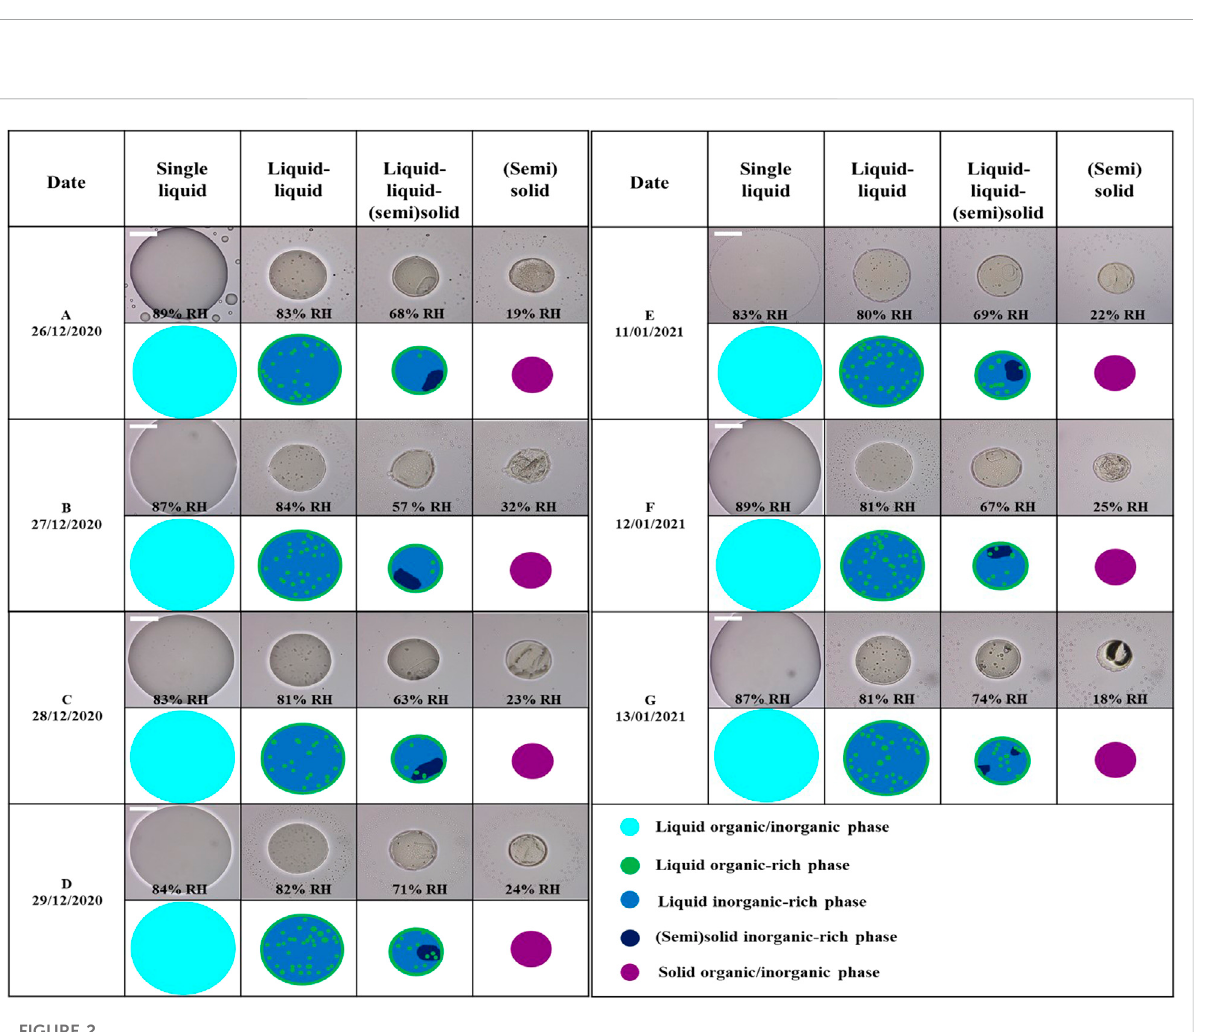
FIGURE 2 Optical images of PM 2.5 fi lter samples collected in winter at Seosan, South Korea, and its cartoon with decreasing RH at ~293 K. The Second, third, and fourth columns represent the single liquid, liquid-liquid, and liquid-liquid-(semi)solid phase states of PM 2.5 , respectively. The fi fth columns represent a (semi)solid phase state showing ef fl orescence over the particles. The scale bar is 20 µm. In the illustration, cyan color: liquid organic/ inorganic phase, green color: liquid organic-rich phase, blue color: liquid inorganic-rich phase, dark blue color: semi(solid) inorganic-rich phase, and purple color: (semi)solid